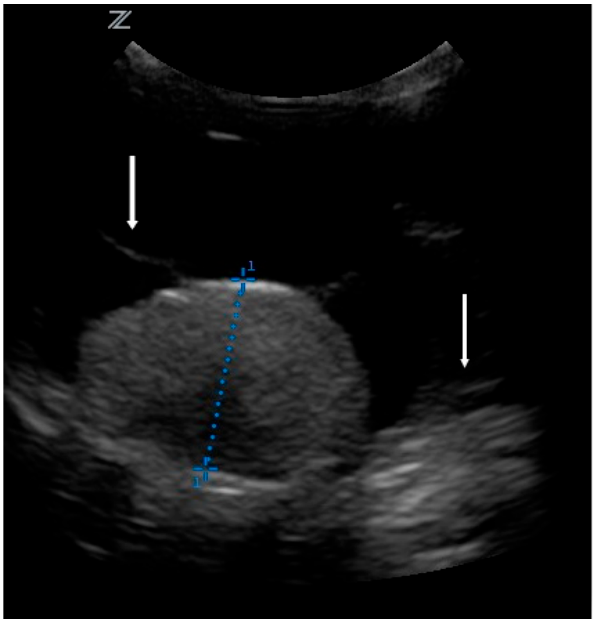
Figure 2. Ultrasonography of the bulbus. Diameter measured: 0.96 cm. Arrows: retina floating in the vitreous body.